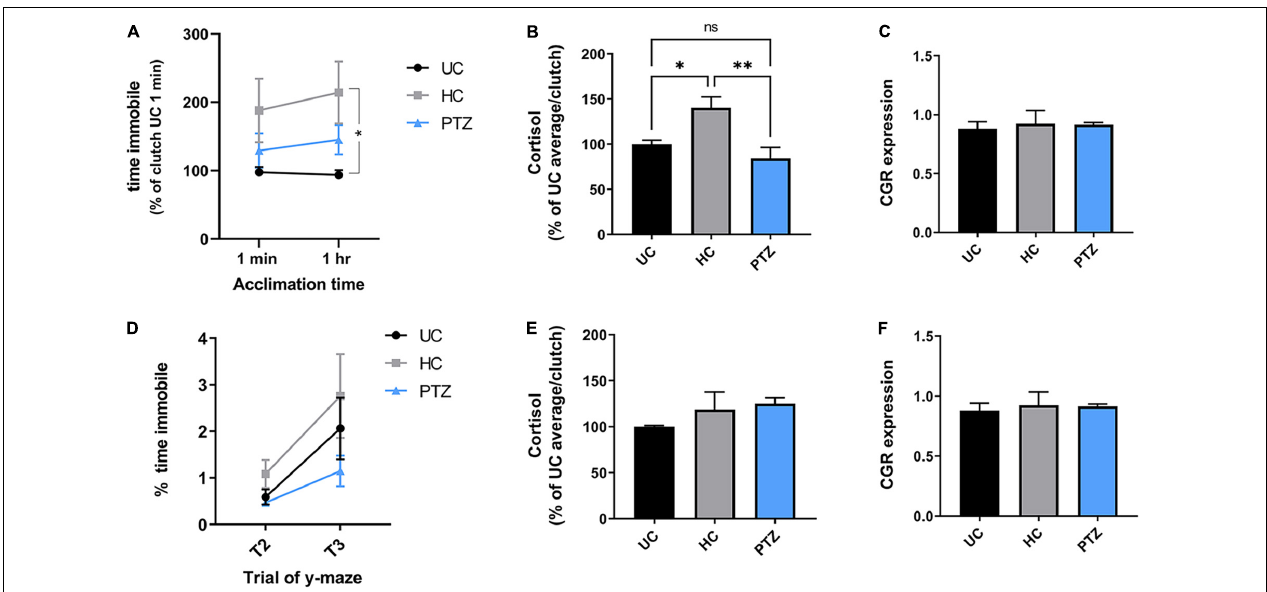
FIGURE 3 | Increased acute stress response in handling control (HC) fish but not pentylenetetrazole (PTZ) fish, at 30 dpf, decreasing by dpf 60. (A,B) HC fish showed heightened stress responses at 30 dpf. (A) Cumulative time immobile during the shoaling assay [normalized to the untouched controls (UC) 1 min average for each clutch]. Two-way repeated-measures ANOVA showed a significant main effect of treatment group [ p = 0.037, F ( 2 , 139 ) = 3.373]. Post-hoc tests showed a significant increase in the HC group at the 1 h time point, as compared to UC ( p = 0.018), though there was a trending increase in HC compared to UC beginning at 1 min ( p = 0.098). There was no significant difference between UC and PTZ ( p = 0.75 at 1 min; p = 0.46 at 1 h). (B) Cortisol levels in 30 dpf fish immediately after netting were significantly higher in the HC group compared to UC ( p = 0.02) and PTZ ( p = 0.004), with no significant difference between PTZ and UC ( p = 0.30). (C) Glucocorticoid receptor mRNA was similar across experimental groups at 30 dpf. (D,E) Freezing and cortisol responses returned to levels comparable UC fish by 60 dpf, and (F) GCR RNA expression remained similar across groups [Freezing, main effect of experimental groups by 2-way repeated-measures ANOVA p = 0.22, F ( 2 , 17 ) = 1.655; n = 7 UC, 7 HC, 6 PTZ]. * indicates p < 0.05; ** indicates p < 0.01; ns or unmarked indicates no significance p >